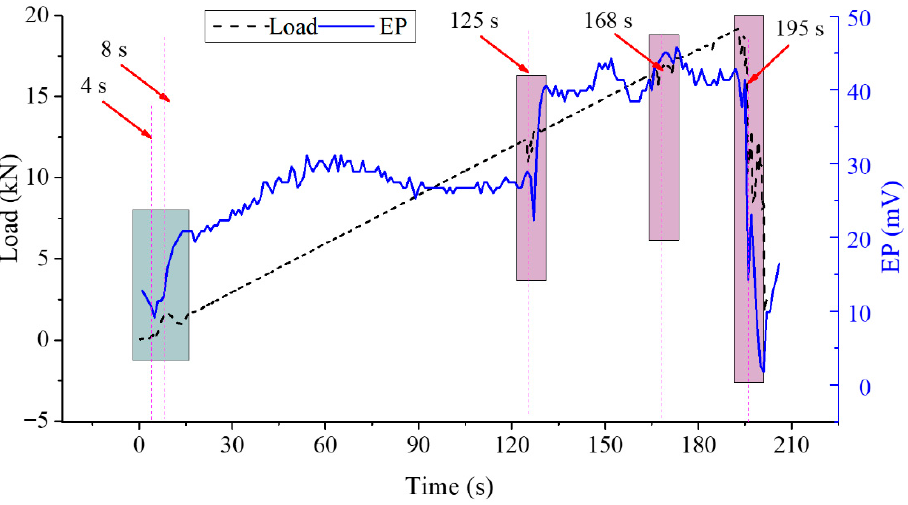
Figure 8. Experimental results of EP response on raw coal specimens under uniaxial compression.